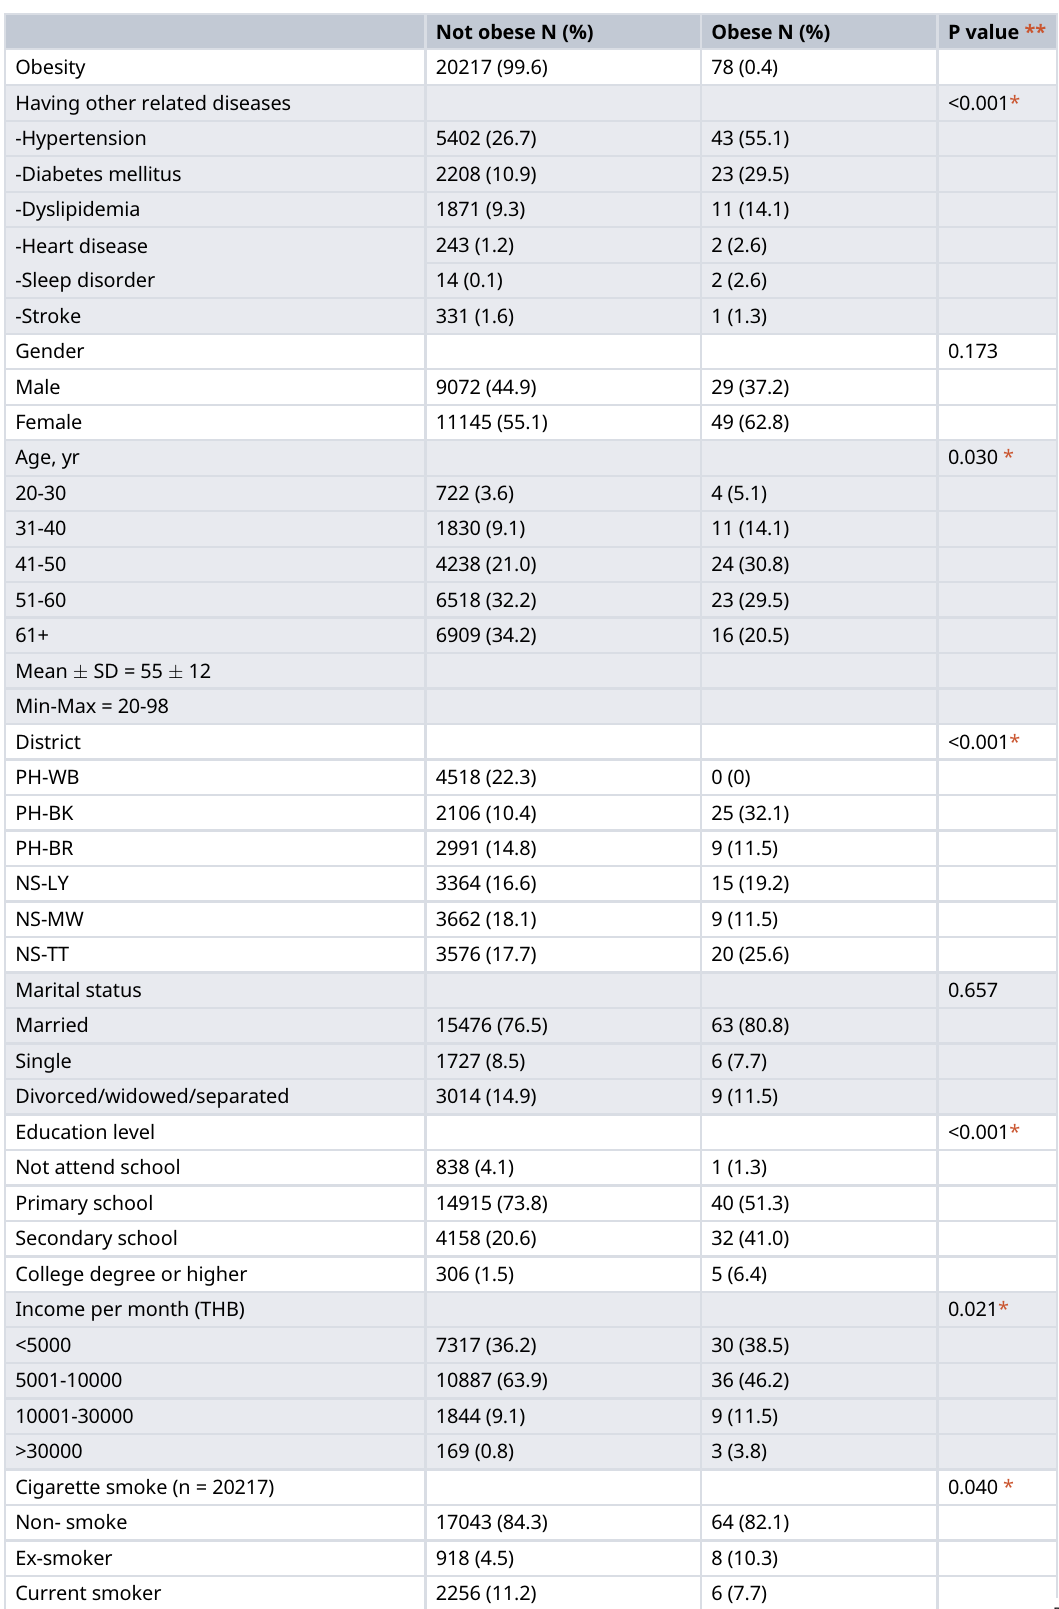
Table 1. Characteristics of not obese, and obese